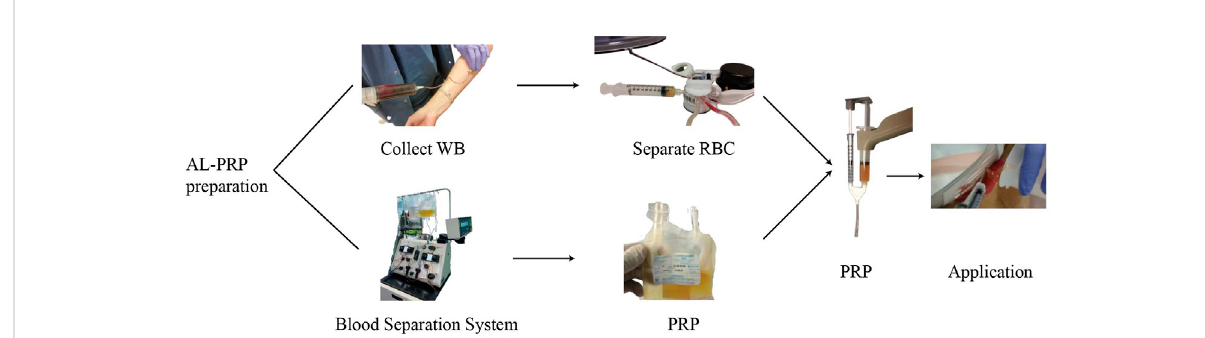
FIGURE 1 A schematic diagram of allogenic PRP treatment. There are two different preparation methodology of allogenic PRP donated from healthy volunteers: manual platelet separation with venous whole blood or platelets apheresis with automatic machine only collected platelets. The allogenic platelet rich gel was used to diabetic foot ulcer after activation by with a mixed solution of thrombin and calcium.